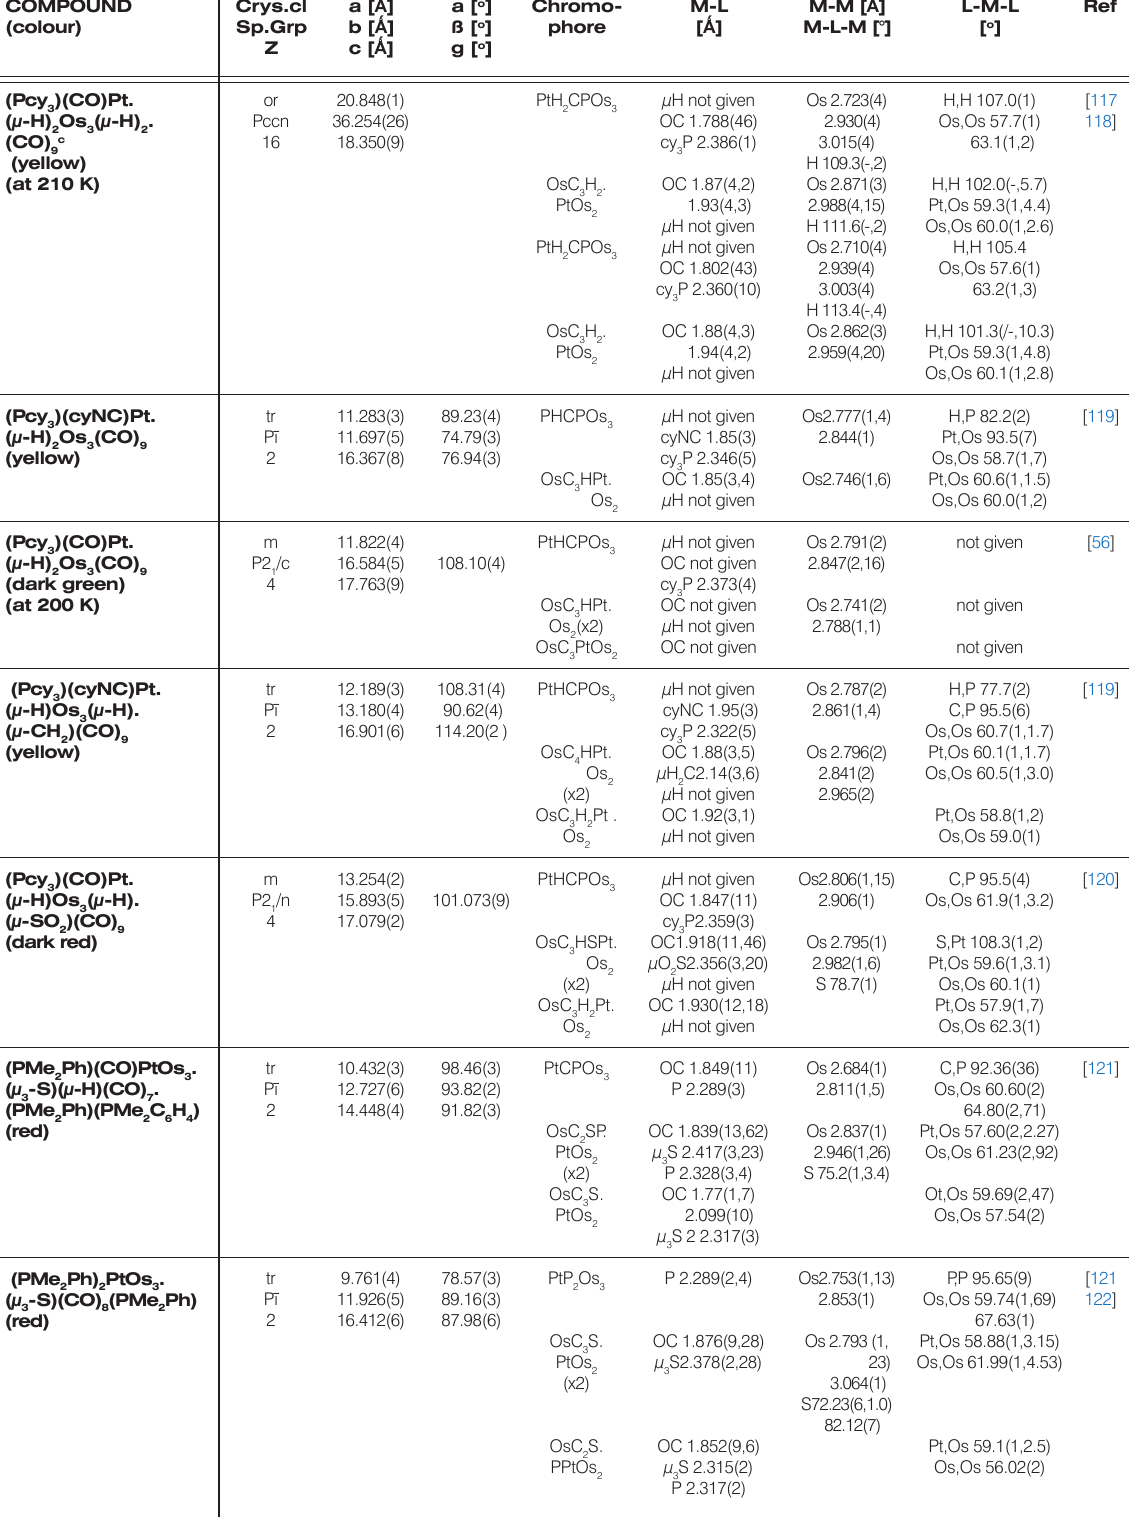
Table 3. Crystallographic and structural data for heterotetranuclear platinum clusters (PtM Continued